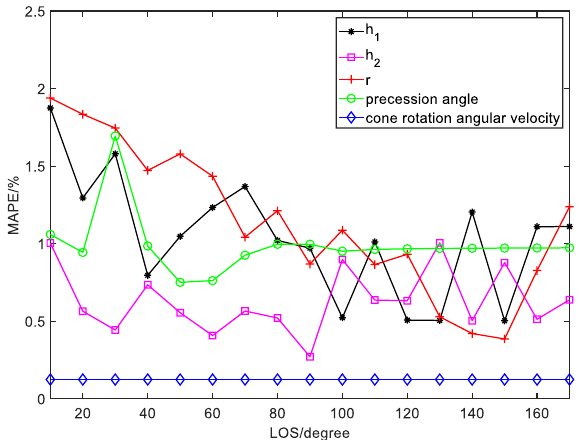
Figure 12. MAPE of different target parameters. (SNR = 4 dB).